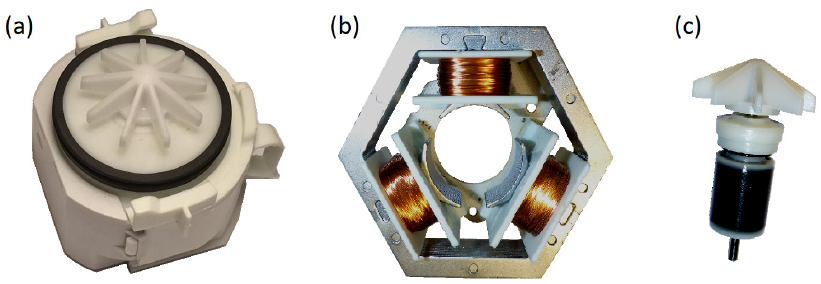
Figure 1. BLDC actuator/motor used in household appliances (54 V, 30 W, 3300 r/min): ( b ) stator and ( c ) ( a ) pomp, ( b ) stator and ( c ) rotor.